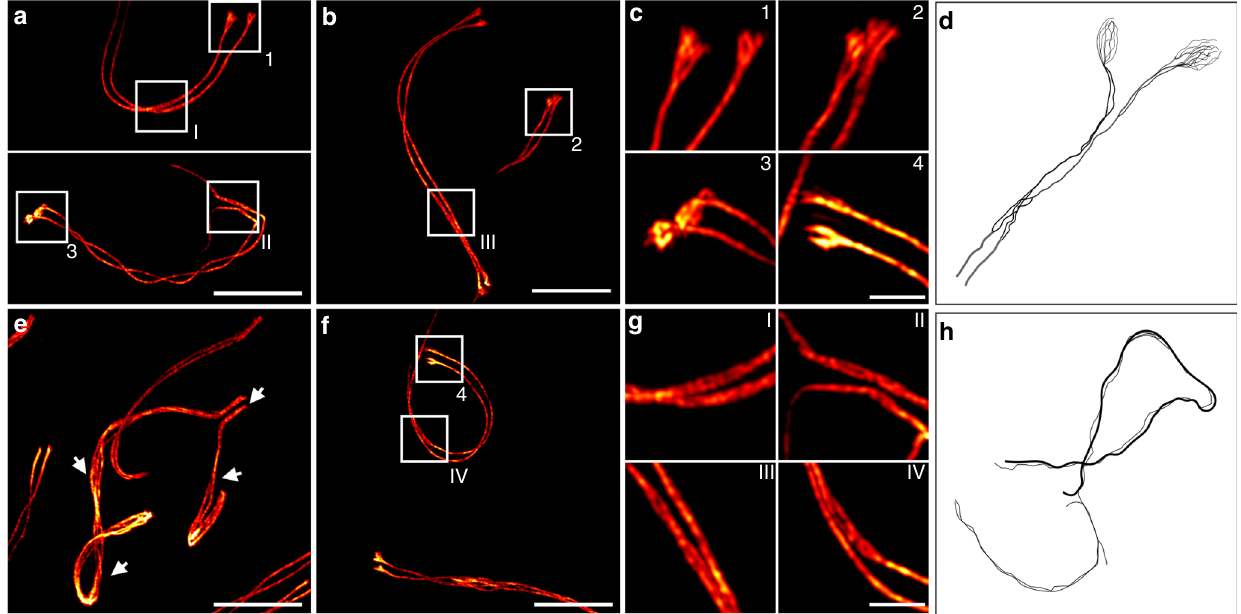
Fig. 5 Structural details of the SC lateral element revealed by MAP-SIM of SYCP3. a – c , f , g The SYCP3 signal shows occasional bifurcation along the two SC strands (I – IV) and various degrees of fraying at their ends depending on the respective pachytene stage (1 – 4). e Unpaired regions of the XY pair (arrowheads) also show a strong degree of fraying. d , h Schematic representations of early EM reports of two or more sub lateral elements (subLEs) in mammals 46,48 in accordance with the splitting of the SYCP3 signal resolved by MAP-SIM in this study. d Representation of the lateral element strand splitting in two and fraying at its end according to literature 46,48 . h Fraying of LEs associated with unpaired regions of the XY pair modeled according to literature 48 . Scale bars, ( a , b ) 7 µ m, ( c ) 1.5 µ m, ( e – f ) 7 µ m, ( g ) 1.5 µ